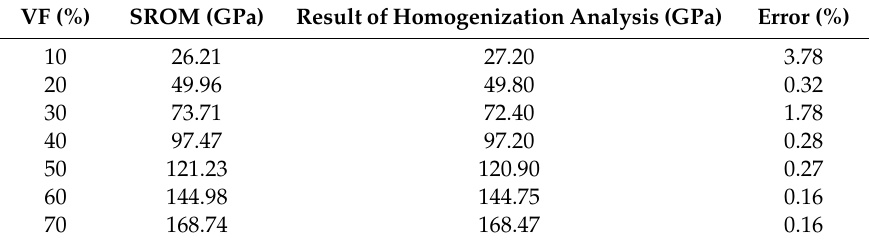
Table 3. Normalized E 11,tow comparison for the rule of mixture and the homogenization analysis result. VF (%)